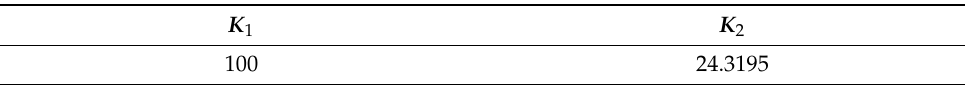
Table 9. DCI controller gains at 90%